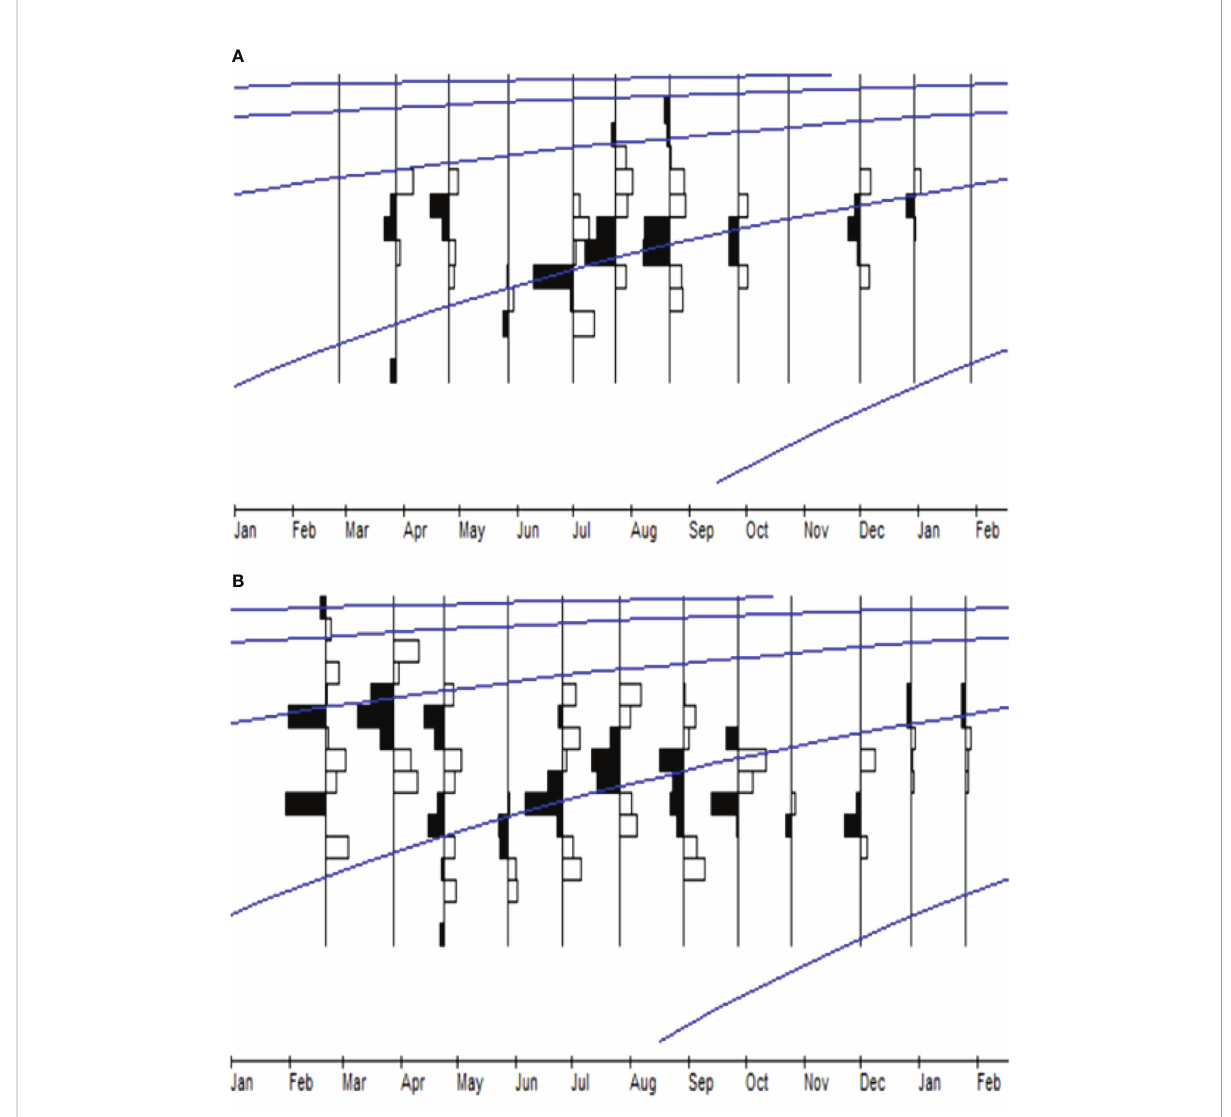
FIGURE 7 Length-frequency distribution data and the growth curves estimated using ELEFAN for (A) female and (B) male P. elegans from the southeast Caspian Sea (2019 –